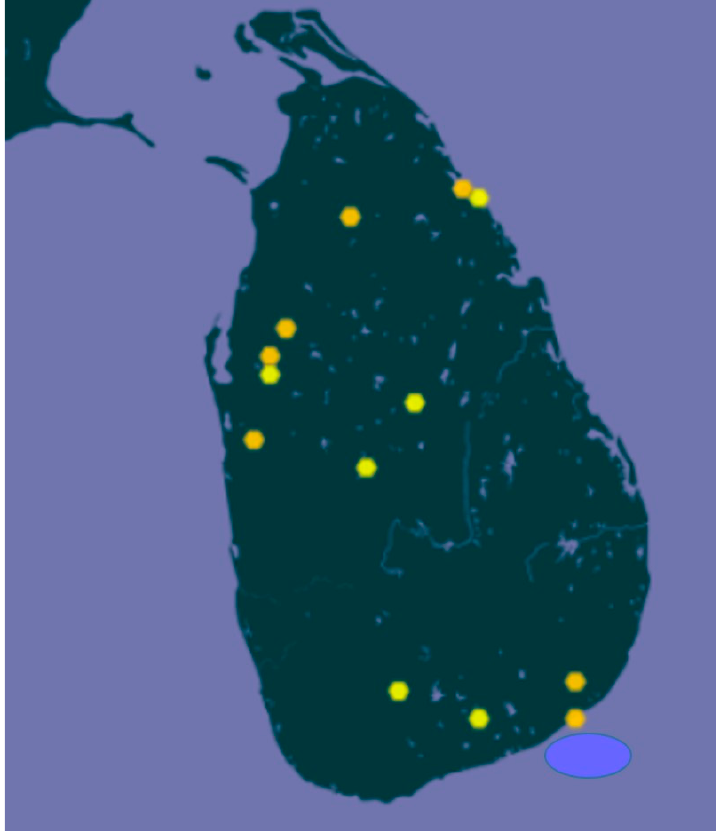
Figure 6. Distribution of Oryza rhizomatis discovered in the late 1980s in the periphery of Yala and Wilpattu National Parks in the driest areas of Sri Lanka [113]. Reproduced with permission from the Food and Agriculture Organization of the United Nations.